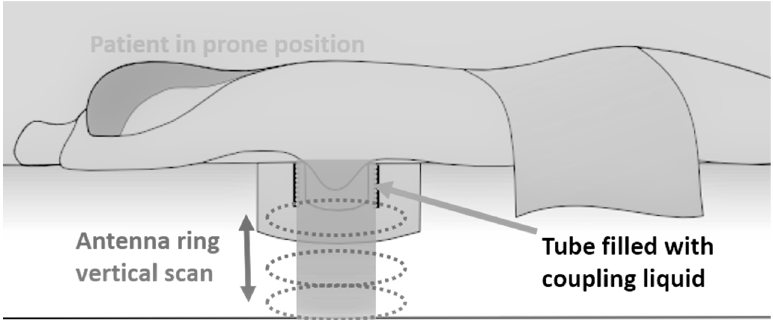
Figure 3. Microwave breast imaging examination: the principle.